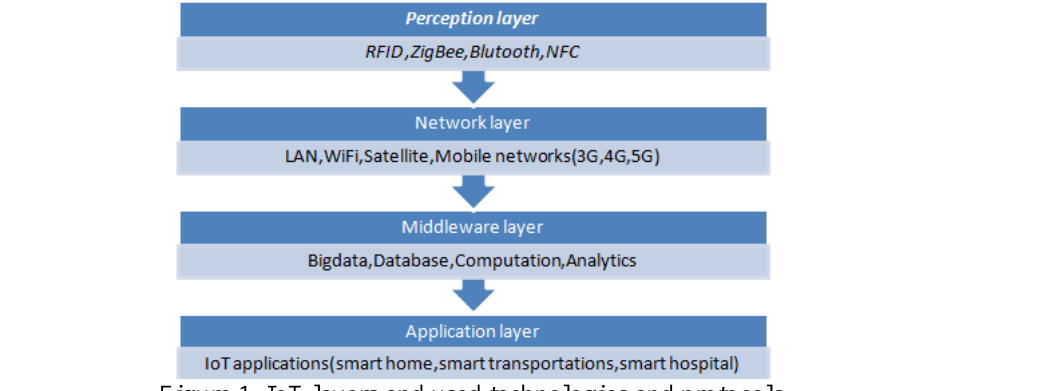
Figure 1. IoT layers and used technologies and